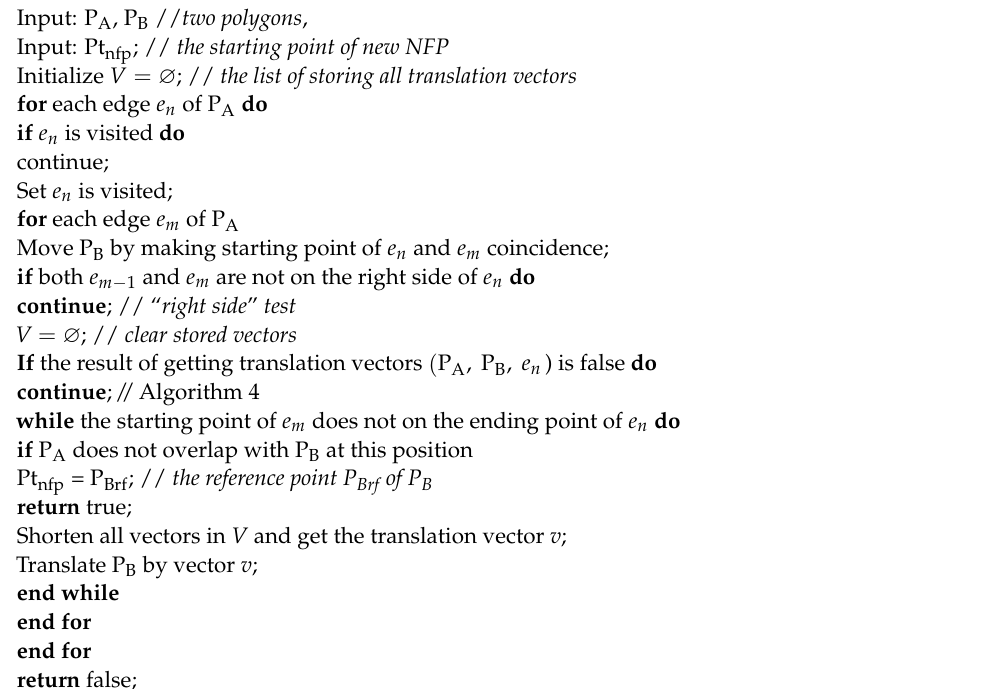
Algorithm 3: Search other Start